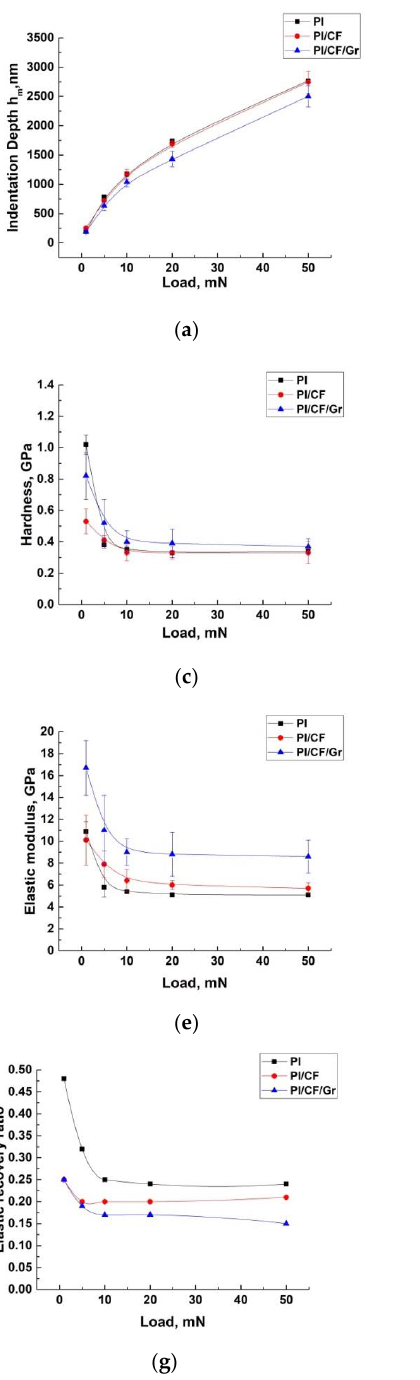
Figure 7. The dependences of the h nanoindenter penetration depth ( a , b ), H hardness ( c , d ), the E elastic modulus ( e , f ), and the elastic recovery ratio ( g , h ) for the wear tracks on both neat PI and PEI, as well as their composites from the load level. Table 4. The nanoindentation data for both neat PI and PEI, as well as their composites at the minimal/maximal load on the Berkovich pyramid.